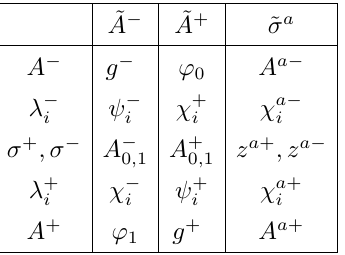
Table 1 . On-shell ( N = 2) SYM × [( N = 0) YM + ( n V − 1)˜ σ ] = ( N = 2) sugra + n V ( N = 2) vector